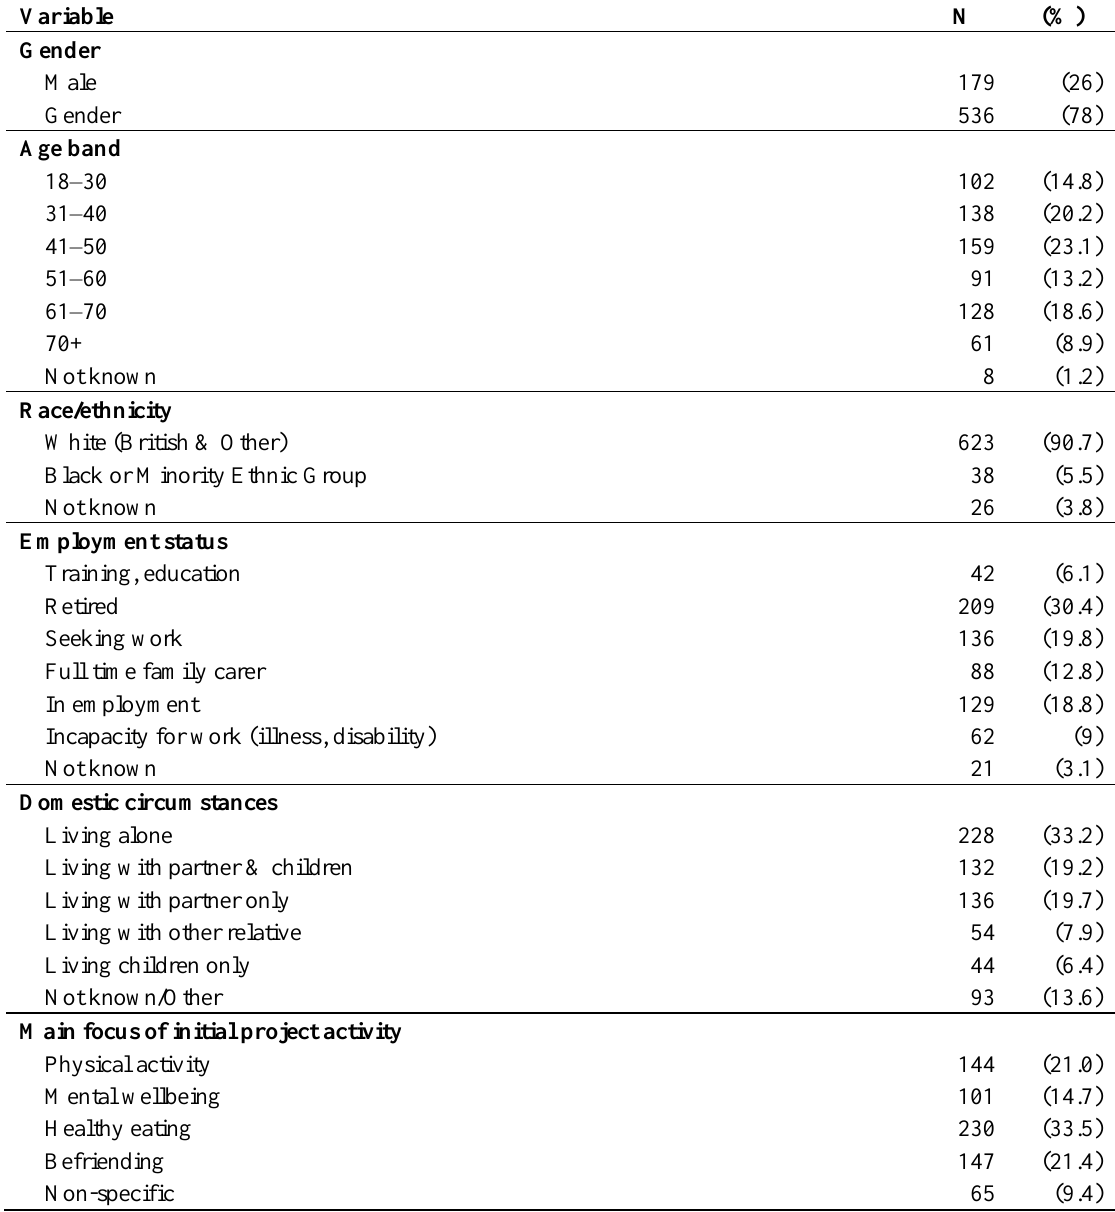
Table 2. Socio-demographic and project activity profile of participants (N =